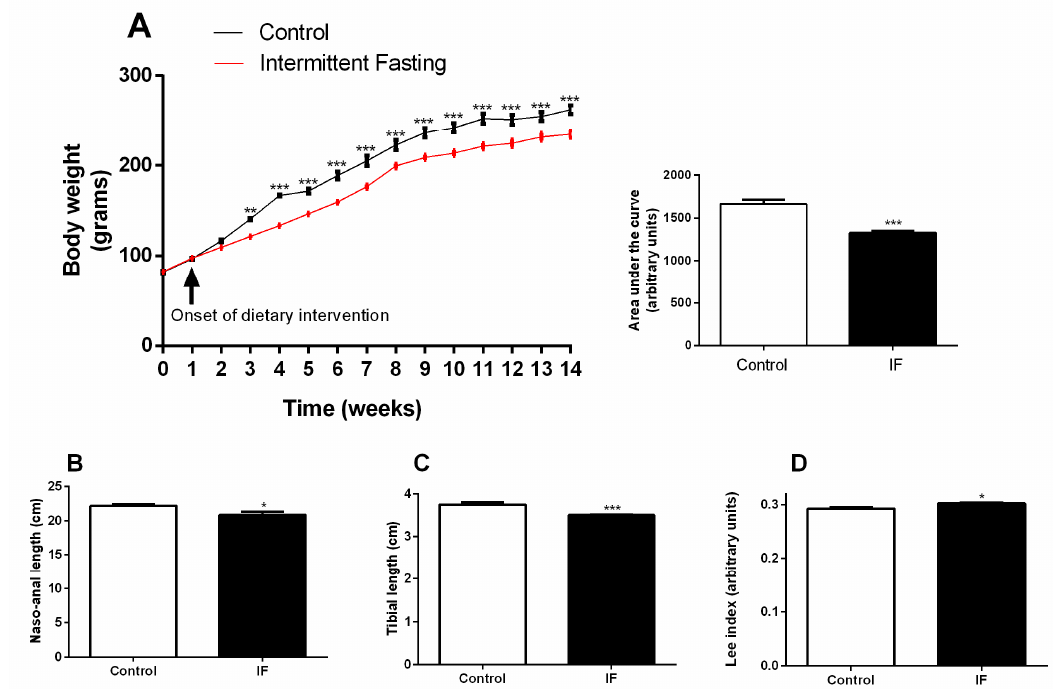
Figure 2. (A) Weekly body weight, ( B ) naso-anal length, ( C ) tibia length, and ( D ) the Lee index of Wistar rats submitted to intermittent fasting (IF) for 12 weeks. The results are presented as the means ± standard error of the mean (SEM) with 10 different animals for each group. * p <0.05, ** p <0.005, and *** p <0.0005 compared to the control of the same period, as indicated by two-way ANOVA followed by Sidak’s multiple comparisons test (A) or Student's t-test (B, C, and D).